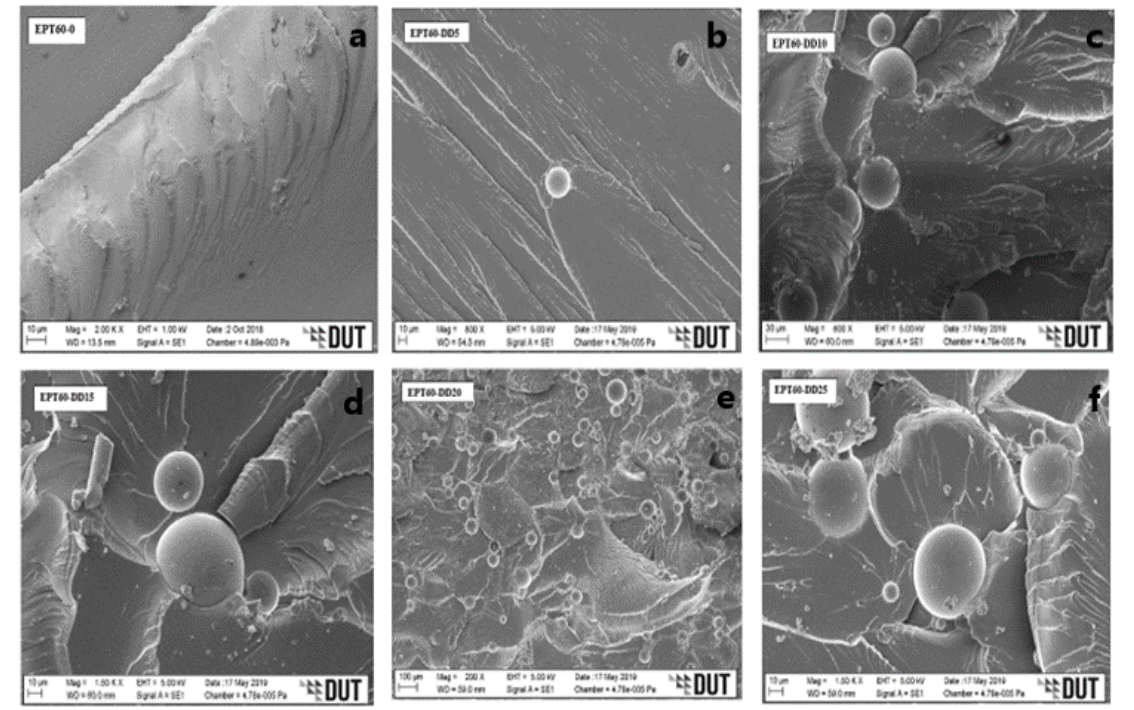
Figure 7. SEM images for flexural fractured specimens of SFC-homogenous HGM at ( a ) EPT60-0, ( b ) EPT60-DD5, ( c ) EPT60-DD10, ( d ) EPT60-DD15, ( e ) EPT60-DD20, and ( f )